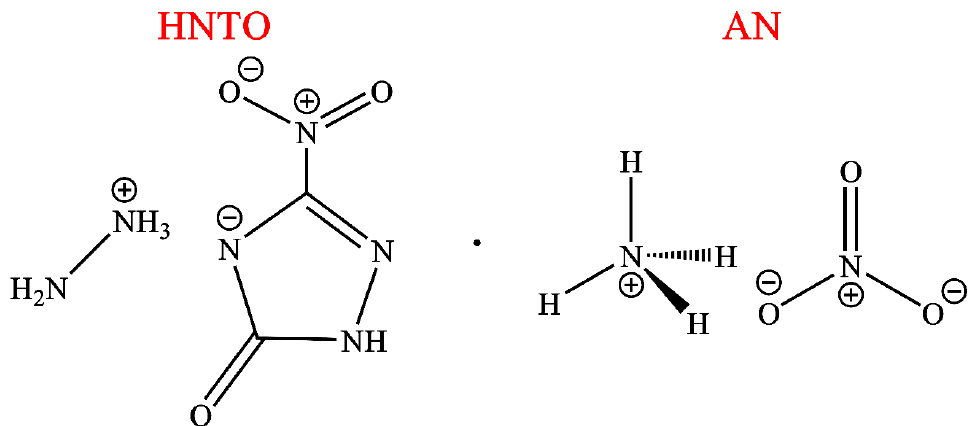
Figure 1. Molecular structure of HNTO ( left ) and AN ( right ).